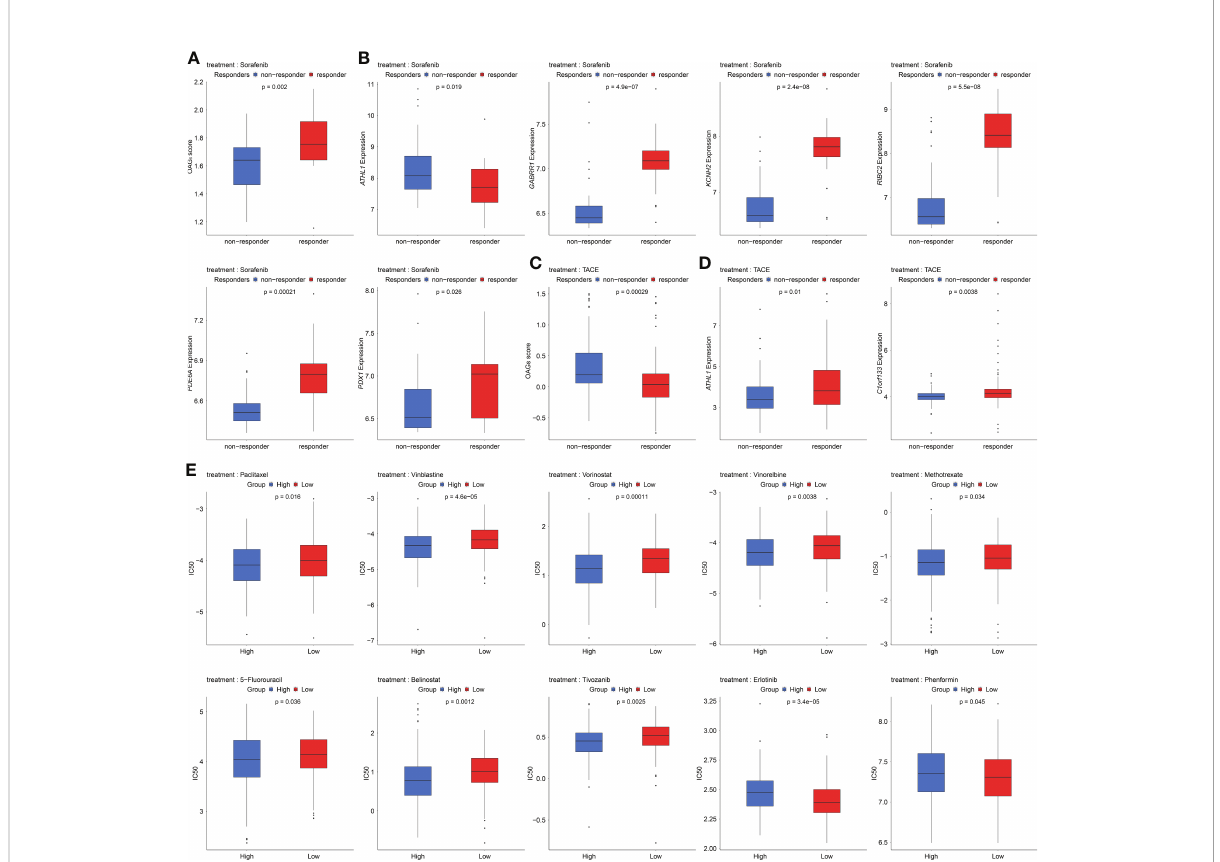
FIGURE 8 Underlying response of sorafenib, transcatheter arterial chemoembolization (TACE), and potential chemotherapeutic treatment regimens. (A) OAG score associated with sorafenib treatment response in GSE109211 dataset. (B) A part of OAG ( ATHL1 , GABRR1 , KCNH2 , RIBC2 , PDE6A , and PDX1 ) expression also correlated with sorafenib treatment response in GSE109211 dataset. (C) Correlation between OAG score and TACE treatment response in GSE104580 dataset. (D) ATHL1 and C1orf133 expression correlated with TACE treatment response in GSE104580 dataset. (E) The GDSC database analysis revealed that OAG score could distinguish patients potentially sensitive to different chemotherapeutic regimens. OAG, overweight/obesity-associated gene; GDSC, Genomics of Drug Sensitivity in